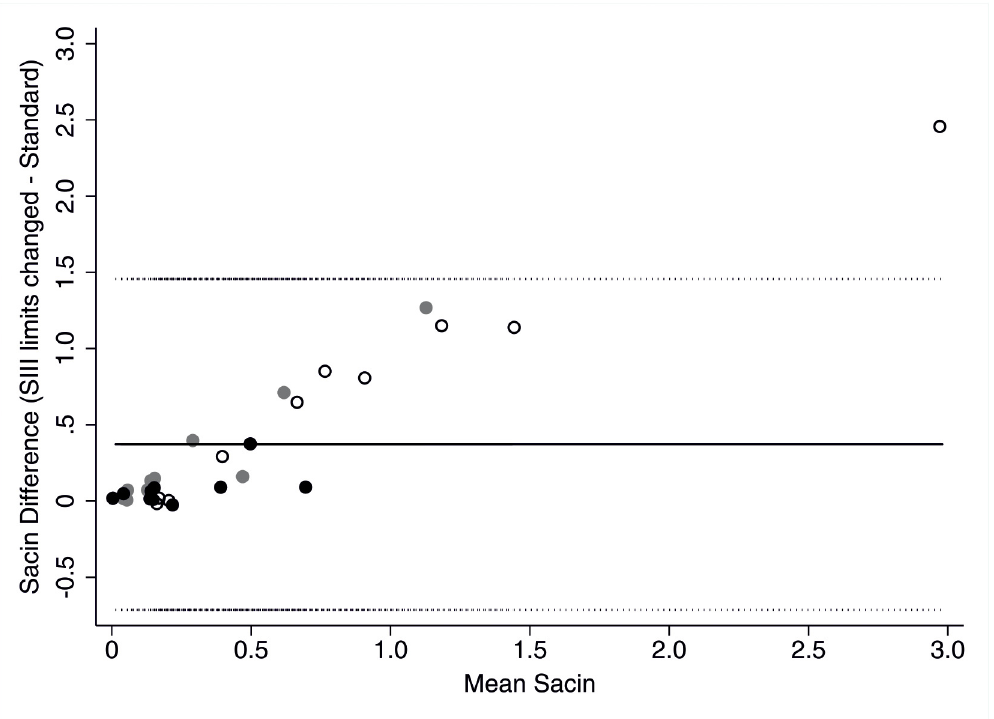
Fig 4. Sacin measurement bias due to changed setting for limits of SIII calculation. Bland Altmann plot of Sacin determined with changed limits for SIII calculation from 65 – 95% to 50 – 80% of expired volume minus baseline Sacin versus mean of Sacin. Black circles represent children with CF, grey circles former preterm and open circles healthy children. Solid line represent mean difference (0.372), dotted lines represent upper (1.457) and lower (-0.713) limits of agreement.